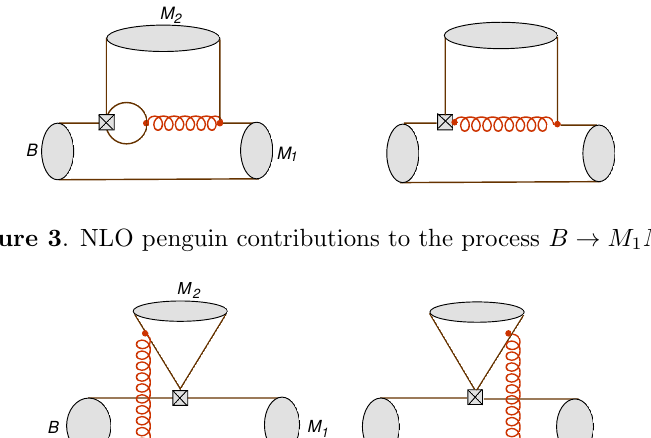
Figure 2 . NLO Vertex contributions to the process B ! M 1 M 2 .